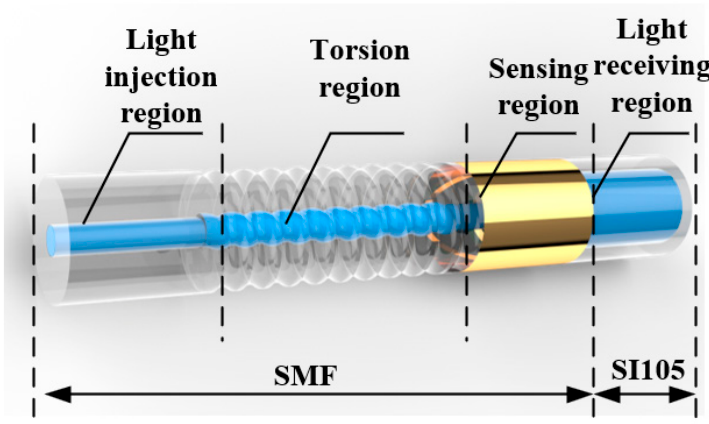
Figure 1. Structure of twisted fiber cladding SPR sensor.